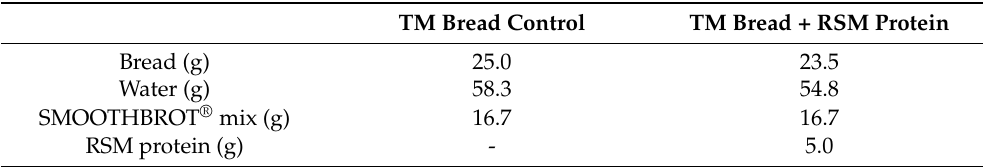
Table 4. Recipe of TM bread without (control) and with the addition of RSM protein isolate. Values are expressed as g 100 g − 1 of fresh